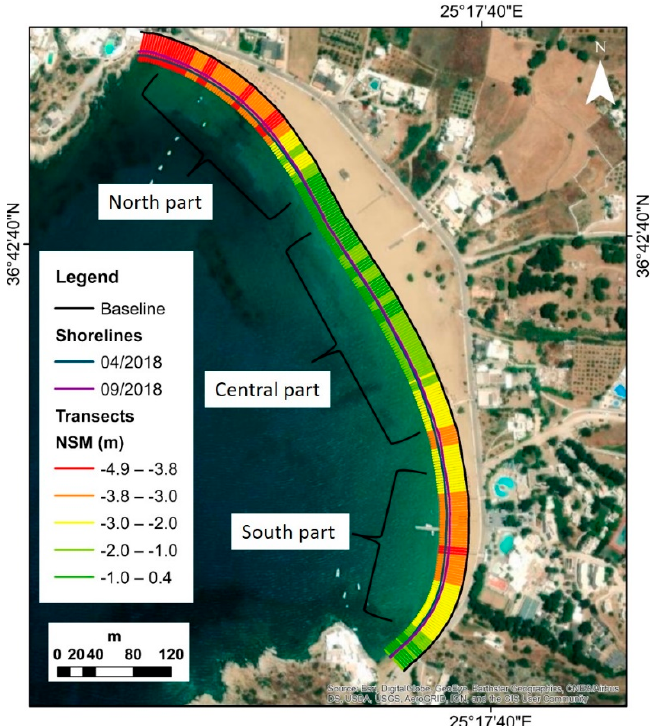
Figure 15. Map of seasonal displacement of the shoreline at Mylopotas beach.